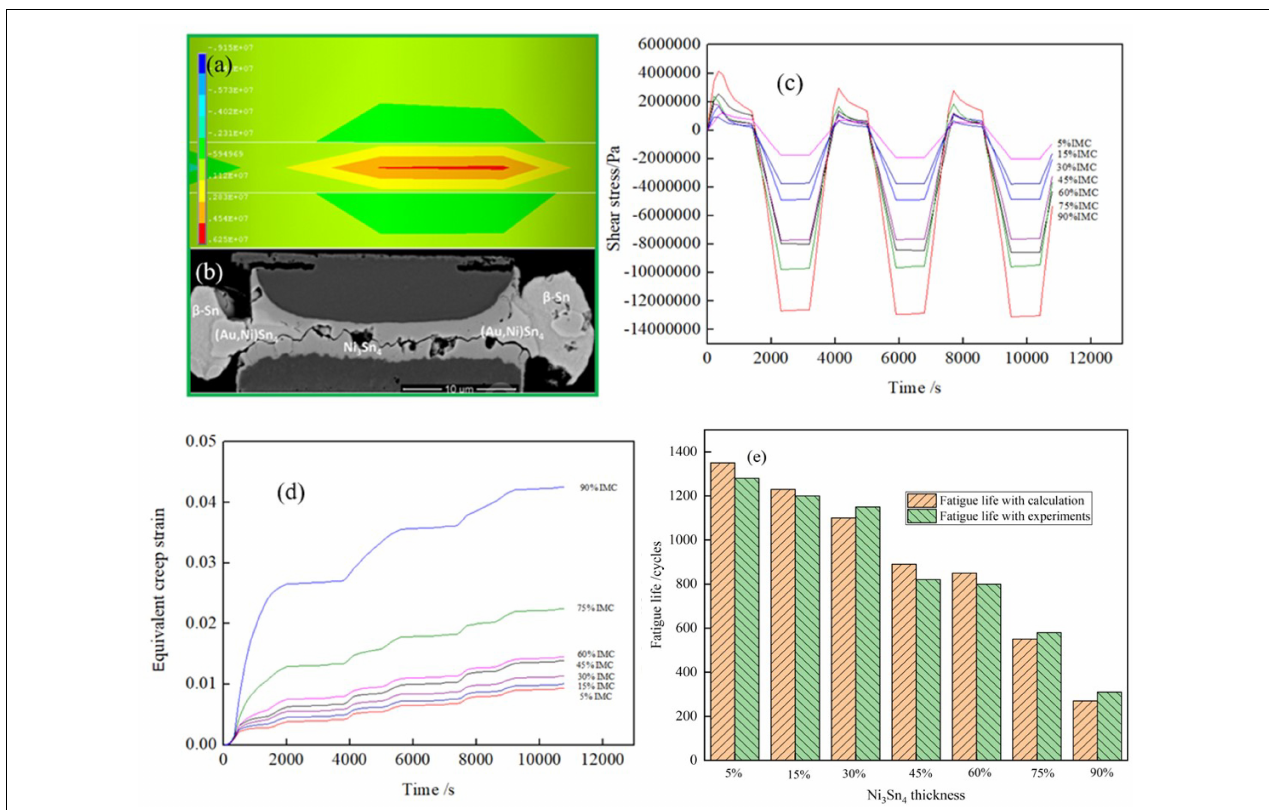
FIGURE 2 | Reliability of solder joints: (a) Shear stress distribution, (b) Failure of solder joints (Liu et al., 2016), (c) Shear stress history of solder joints, (d) Equivalent creep strain, and (e) Fatigue life of solder